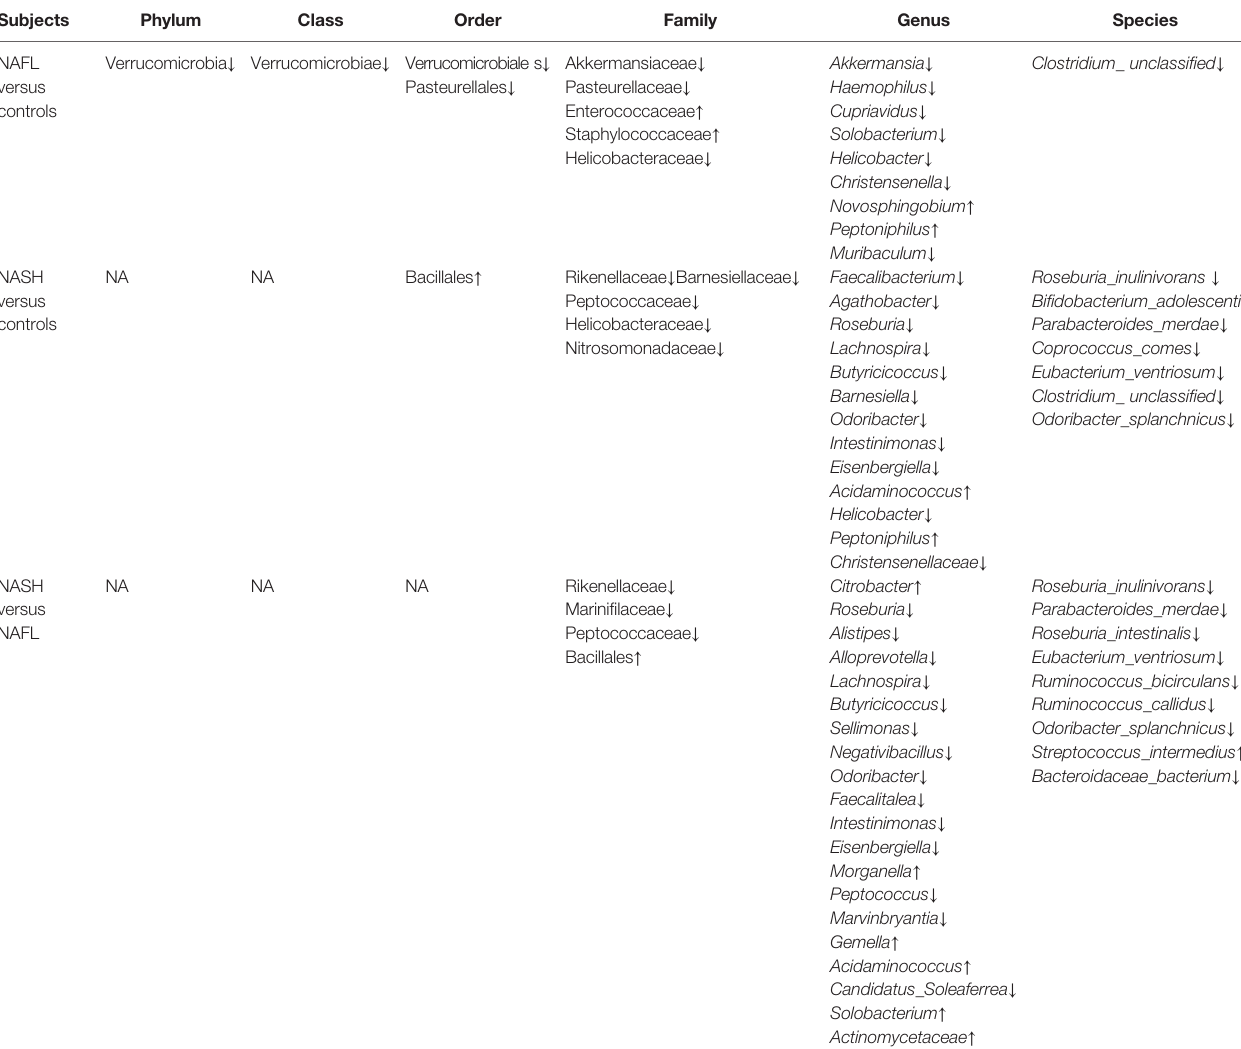
TABLE 2 | Gut microbiota in different groups.